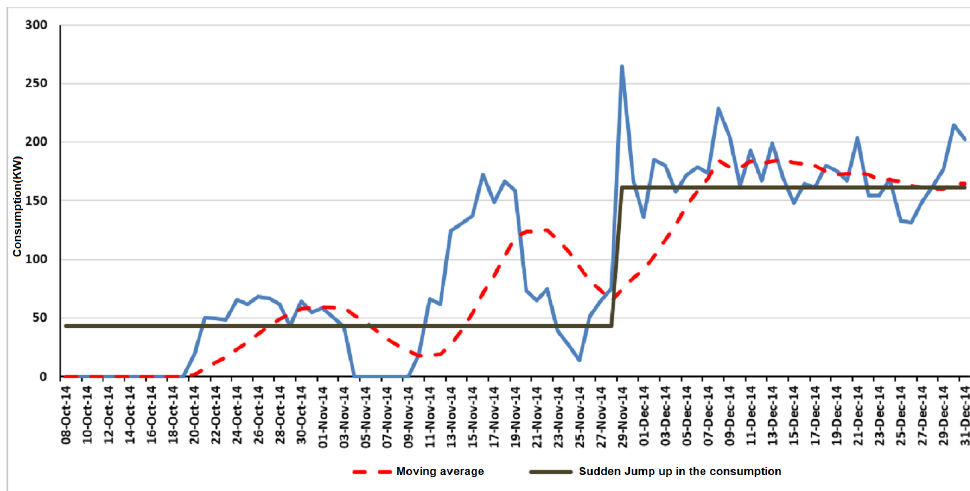
Figure 3. Sudden Jump up detection in the average Smart Meter usage of the attacked meter. The smart meter consumption in blue. The jump in between the mean of lag meter readings and the mean of the lead meter-readings (black color) at the fraudulent point. The moving average of the smart meter readings (red